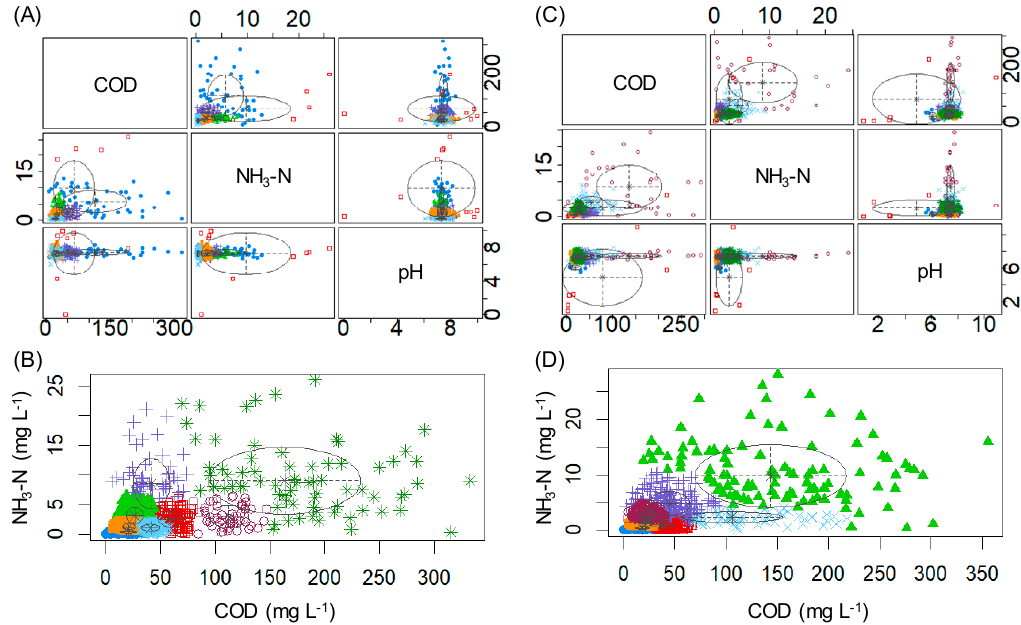
Figure 4. Data distribution vs. classifications of the YRB sewage outlets using EM clustering and the yearly means of COD, NH 3 -N, and pH in wastewater discharged in 2016 ( A : the EM_A method and B : the EM_B method) and 2017 ( C : the EM_C method and D : the EM_D method) (di ff erent shapes and colors indicate di ff erent EM clusters).